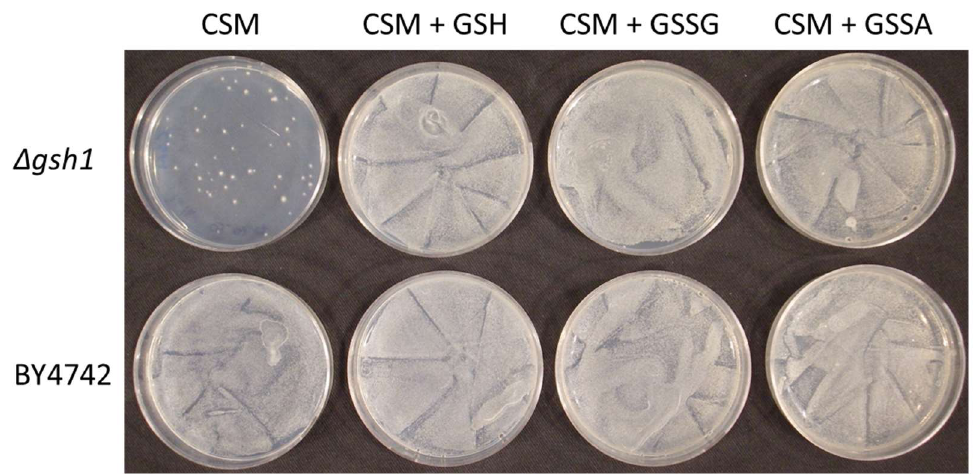
Figure 3. Growth of the wild type BY4742 yeast strain compared with the Δgsh1 mutant on complete synthetic mixture (CSM) and CSM supplemented with 10 mM glutathione (GSH), 5 mM glutathione disulfide (GSSG) or 10 mM S -allylmercaptoglutathione (GSSA). A 100 µL aliquot of a logarithmically growing yeast culture adjusted to OD 600 = 0.2 (OD = optical density) was spread onto the surface of each plate with a Drigalski spatula.